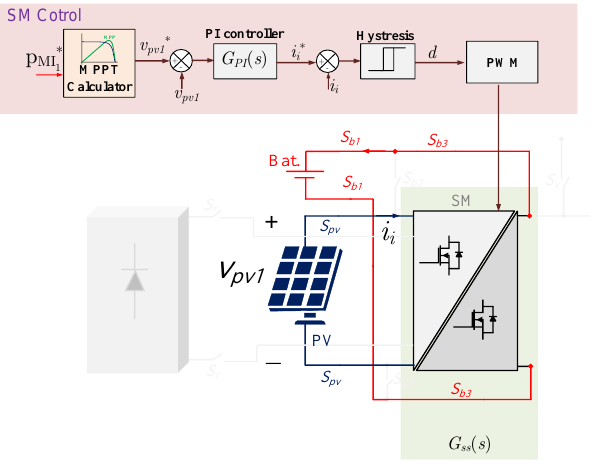
Figure 15. SM control during Mode 2.